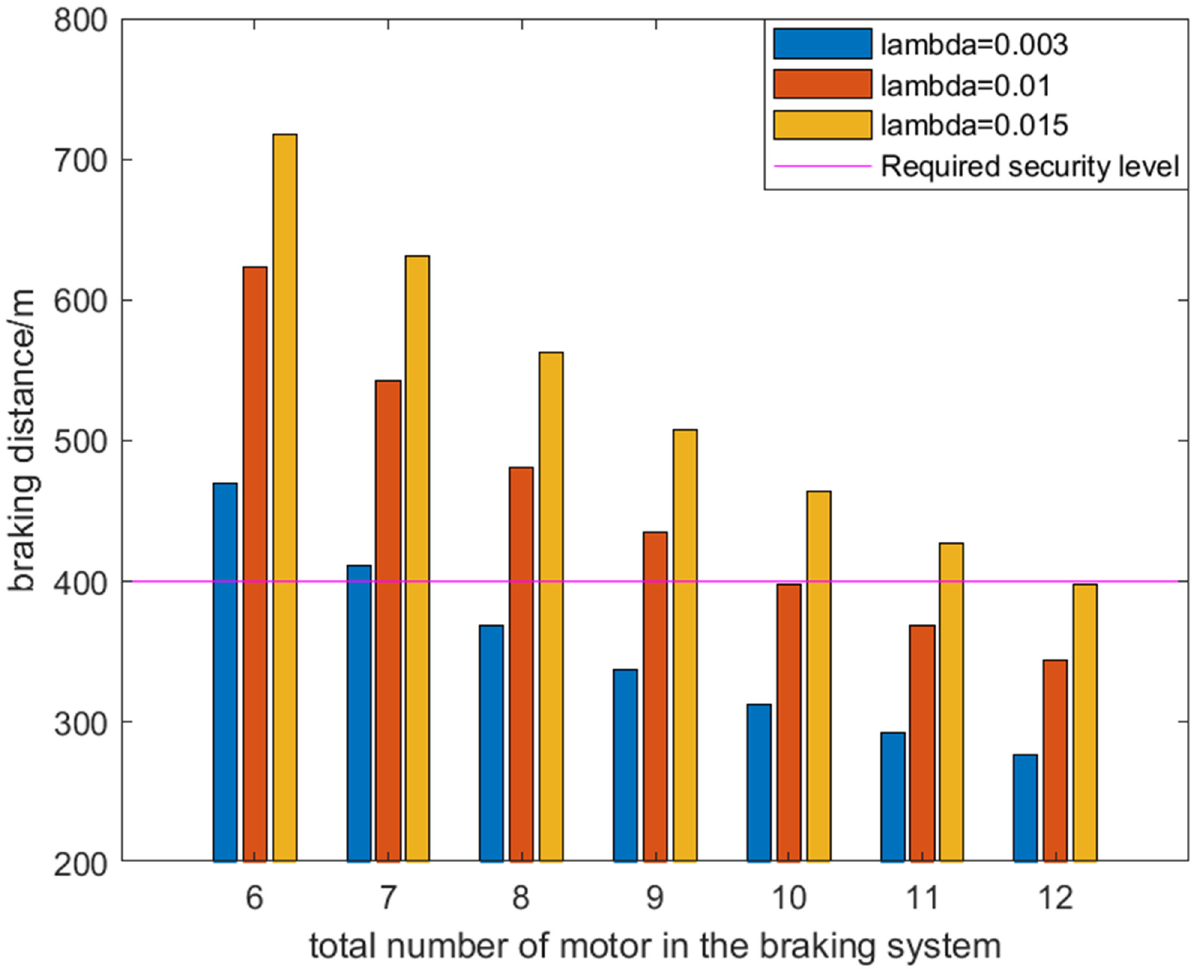
Figure 7. Braking distance verified with different number of motors.